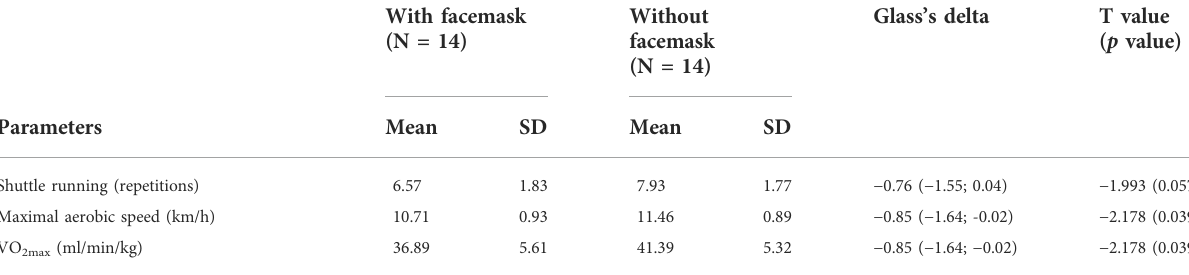
TABLE 1 Comparison of physical performance measures while wearing or not a facemask.